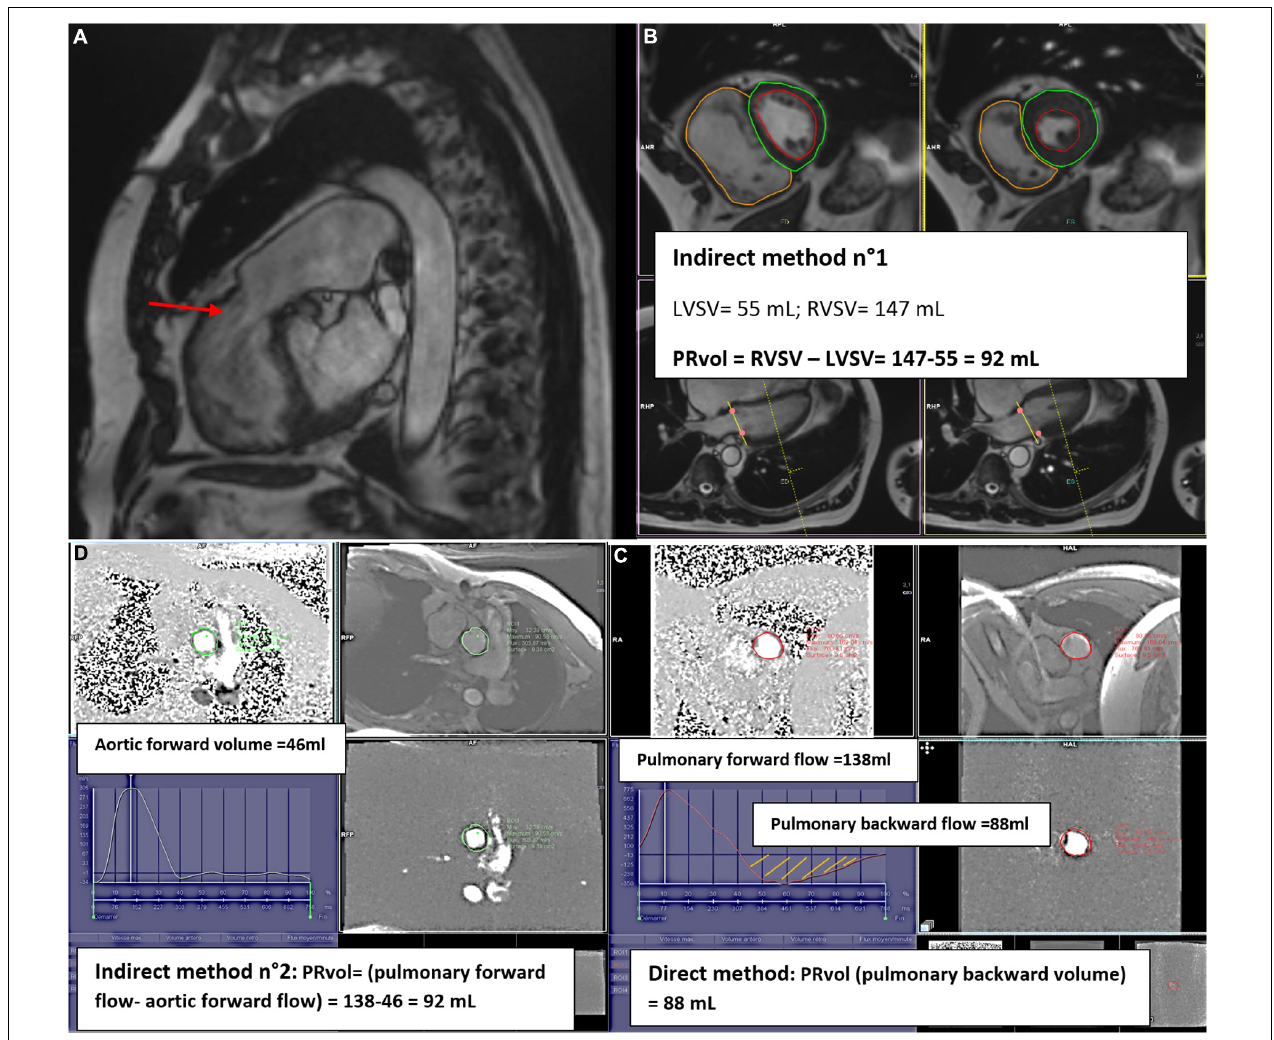
FIGURE 9 | Cardiac magnetic resonance examination of a patient with severe pulmonary regurgitation (PR) using 3 different methods. RVOT view, showing flow void of PR (red arrow) (A) . PR quantification with the indirect method n ◦ 1 (B) : Assessment of left (LV) and right ventricular (RV) size and function by cine bSSFP; RV is severely enlarged, with a D shape (diastolic RV overload); PR Volume is the difference between RV and LV stroke volumes (SV). PR quantification with the direct method (C) : phase contrast flow mapping showing pulmonary forward volume at 138 mL and pulmonary backward volume of 88 mL [area under the diastolic flow curve (orange hatch lines)] corresponding to PRVol. Phase contrast flow mapping above the aortic valve, allowing aortic forward flow calculation at 46 mL. The difference between pulmonary and aortic forward flow gives PRvol (92 mL) (D)